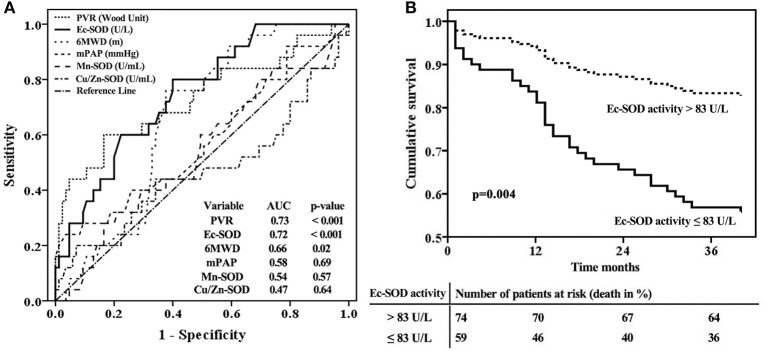
Extracellular form of Cu/Zn superoxide dismutase (Ec-SOD) activity in relation to other markers for an adverse prognosis according to (A) receiver operation characteristic analyses and (B) survival curves for the baseline cutoff plasma Ec-SOD activity in patients with idiopathic pulmonary arterial hypertension, adjusted by age and female gender. The best Ec-SOD cutoff level for predicting outcome was 83 U/L. Survival was significantly better in patients with Ec-SOD activity >83 U/L.